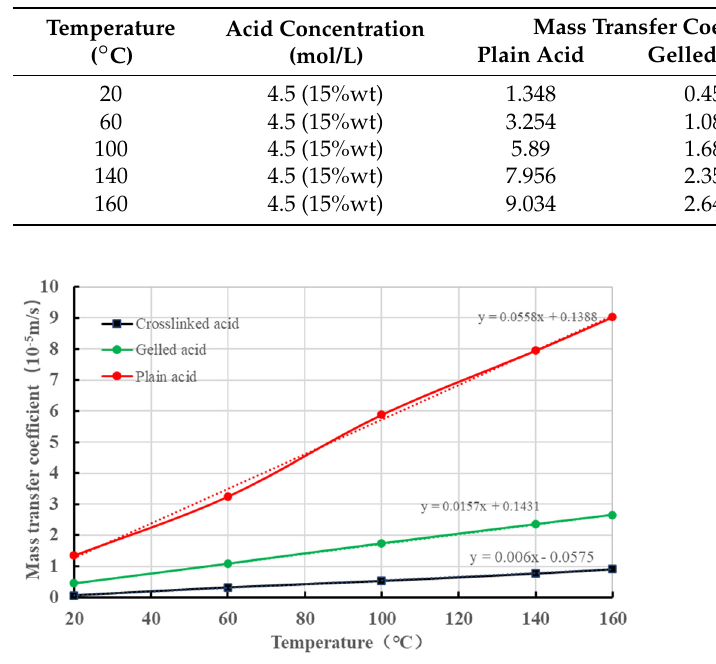
Figure 6. Modeling the temperature dependence of mass transfer coefficients for three acid species.